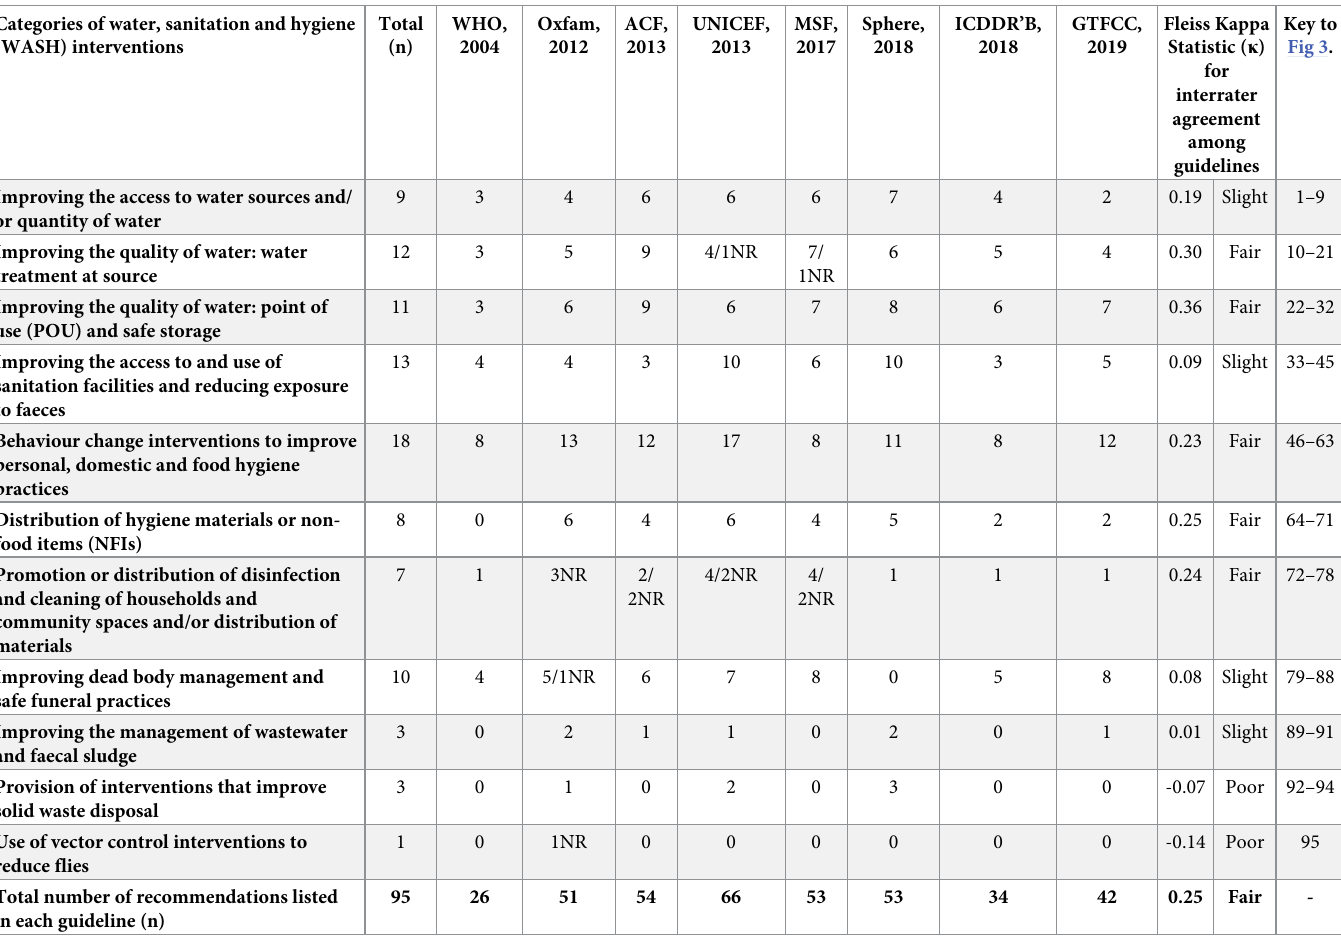
Table 3. Number of recommendations listed by each guideline, classified by WASH intervention category and analysed for concordance among guidelines. Categories of water, sanitation and hygiene (WASH)